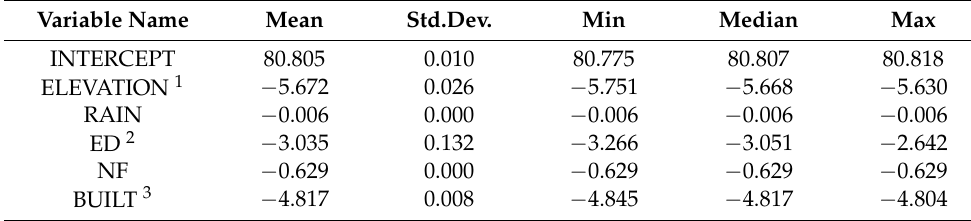
Table 6. Statistical description of the MGWR model coefficient for female